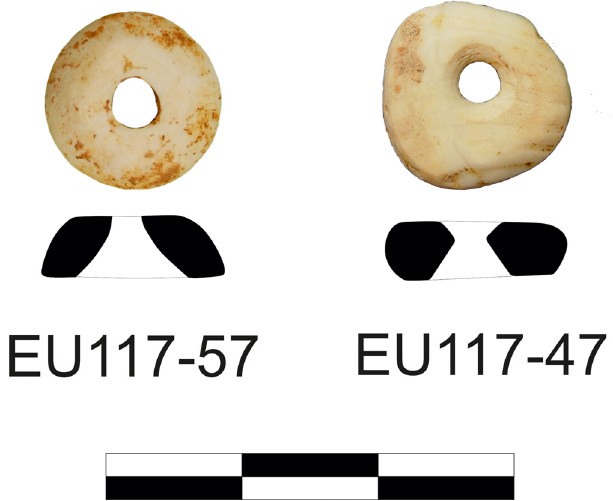
Figure 6: Ornamental elements documented inside the combustion